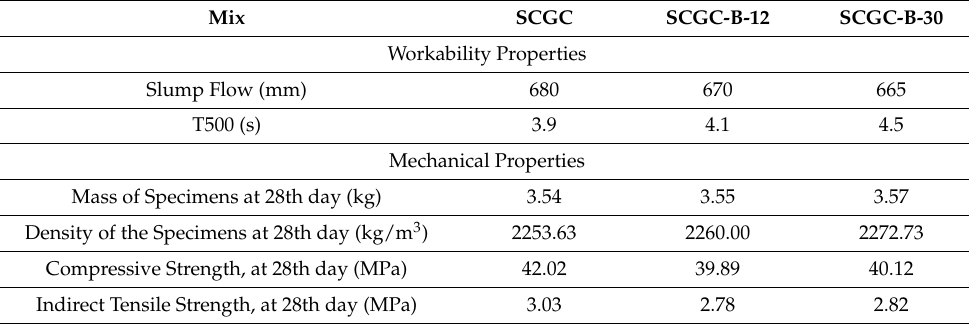
Table 3. Workability and Mechanical Properties of the Geopolymer Concrete